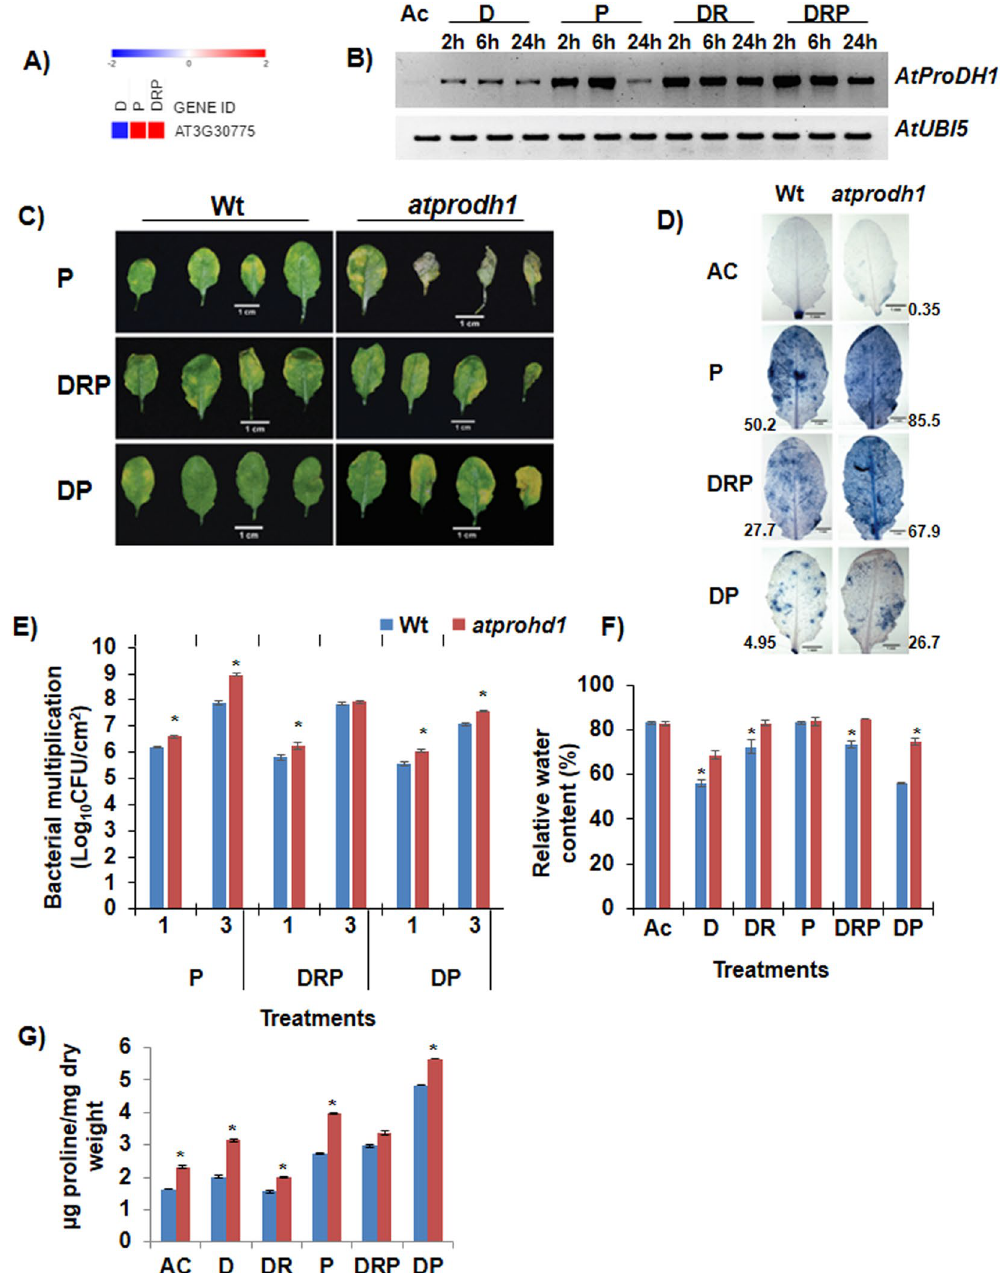
Figure 4. AtProDH1 gene modulates plant tolerance under combined stress. atprodh1 mutant and wild-type (Wt) plants were exposed to individual drought (D, at 40% FC), pathogen (P, at 10 4 CFU/mL) and drought recovery (DR) and combined drought recovery-pathogen (DRP) and drought-pathogen (DP) treatments. Heat map showing expression pattern of AtProDH1 gene (AT3G30775) was drawn using linear fold change values (D over C and P, DRP over M) from microarray-based transcriptome profile and is presented here ( A ). Colour bar in blue and red shows down- and up-regulated expression respectively. AtProDH1 transcript expression is shown in WT plants under D, P, DR, DRP and DP stress at 2, 6 and 24 hpt. Semi-quantitative reverse transcriptase PCR was performed with 50 ng of total RNA for 34 cycles. Ubiquitin ( AtUbi5 ) gene expression was studied as a reference in the respective samples and is presented as loading control ( B ). Diseased leaves exhibit chlorosis or cell death. Disease phenotype was captured at 4 days post treatment (dpt) in WT and atprodh1 mutant plants under individual and combined stress treatments and is presented for four biological replicates ( C ). Disease-associated cell death was captured using trypan blue staining at 3 dpt in Wt and atprodh1 plants in three biological replicates. The extent of cell death is directly proportional to the intensity of blue colour and is represented as fold change over absolute control along each image (ImageJ software) ( D ). Bacterial multiplication in inoculated plants (P, DRP and DP) was monitored at 1 and 3 dpt. Bars represent the mean and SEM for eight biological replicates. Statistical significance for a particular treatment in the mutant plant was determined over respective Wt using student’s t -test. Asterisk represents statistically significant value at P <